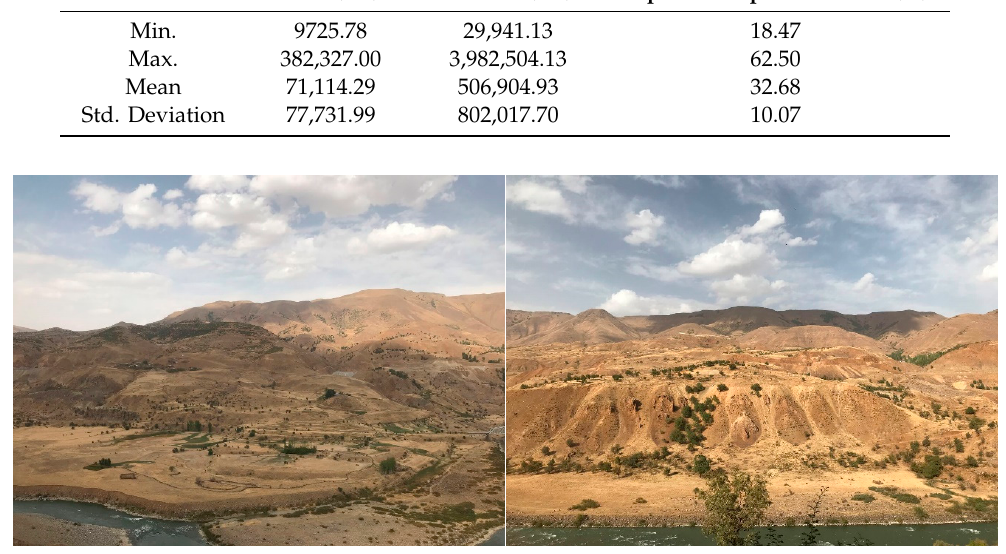
Figure 2. Photos showing the typical landslide morphology in the study area (Photos from the area taken before the dam construction).